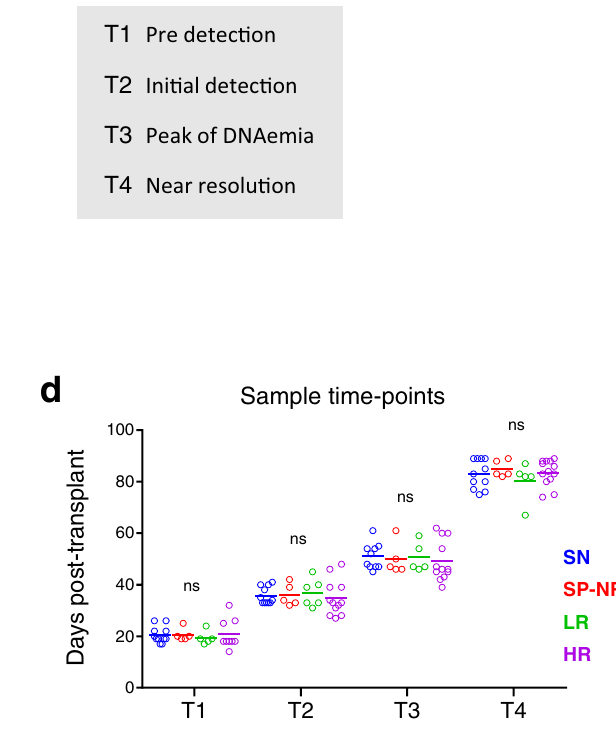
time-point, we used signi fi cance analysis of microarrays (SAM) to compare all immune subsets analysed between patients with or without HCMV reactivation, examining both cell proportions (Fig. 3a) and absolute counts (Fig. 3b). At T1, absolute counts of total CD4 + T cells and CD4 + T cell subsets appeared lower in ‘ reactivators ’ (LR and HR) compared to ‘ non-reactivators ’ (SN and SP-NR) (Fig. 3b), while no signi fi cant differences in cell